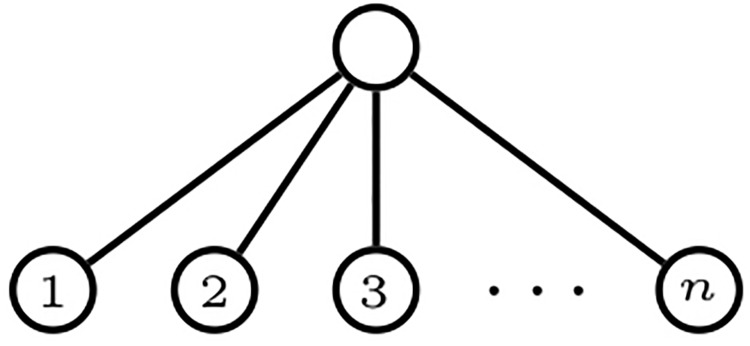
A star FSn with n leaves.